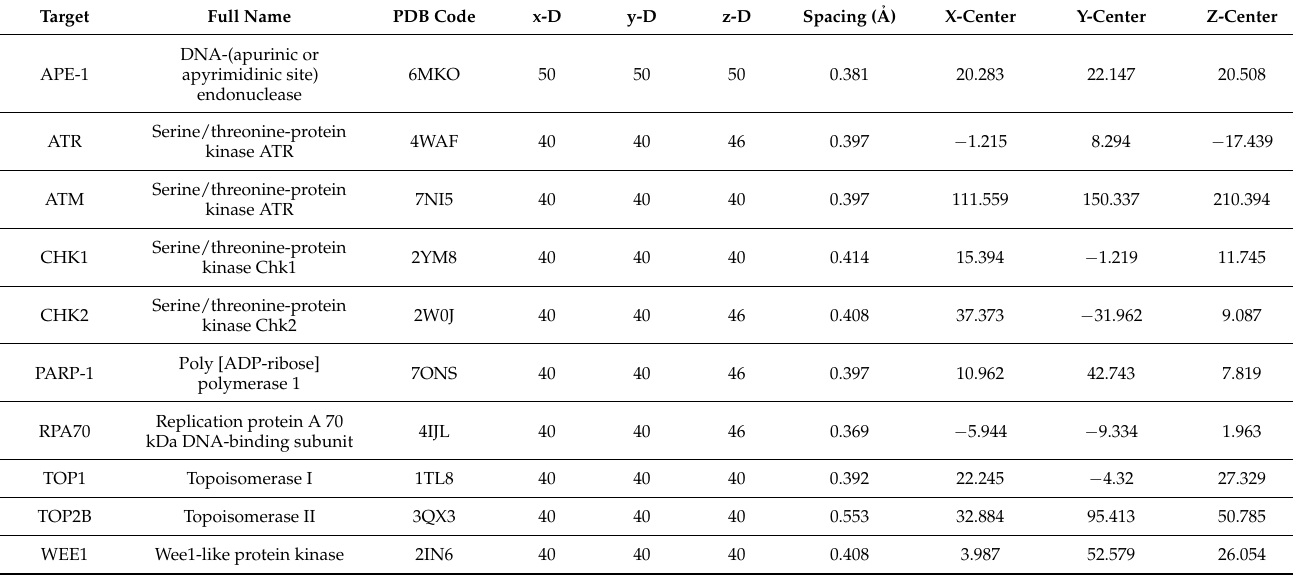
Table 3. Grid box coordinates used in molecular docking studies: the coordinates of the grid box for all of the macromolecular targets belonging to the DDR pathway used in the current